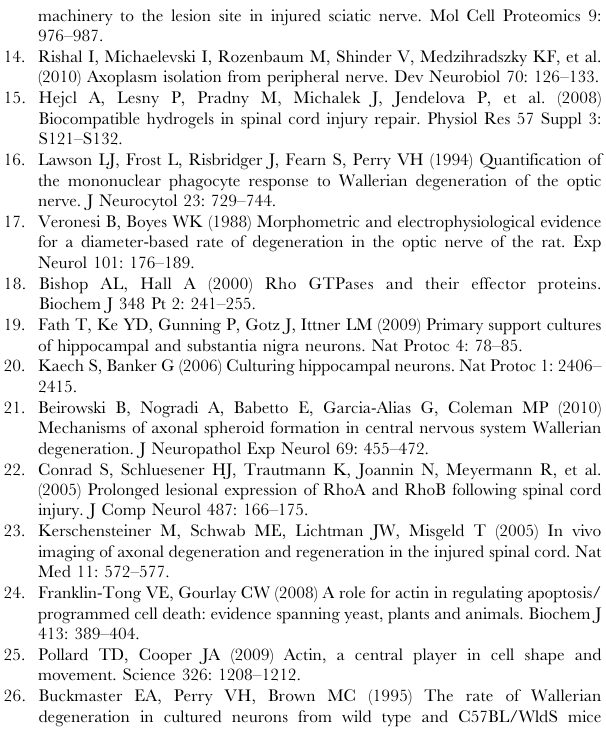
Figure S1 Functional characterization of protein chang- es identified after axon injury. Using Panther software and database searches, proteins were assigned to a particular molecular function. Pie charts illustrate the frequency of protein changes belonging to each group at 24 hours (A) and 48 hours (B) after injury. Figure S2 Samples from perfused animals are not contaminated with blood borne components. Equally loaded samples (5ug/lane; coomassie stain in bottom panel) corresponding to o ptic nerve homogenate (H( + p)) and axoplasm- enriched (Axo) from perfused animals were compared to homogenates from unperfused animals (H(-p)) and a 1/10 dilution of rat sera as a positive control. Neither the heavy or light chain of technique; in contrast, samples from unperfused animals showed a signal for the heavy chain of